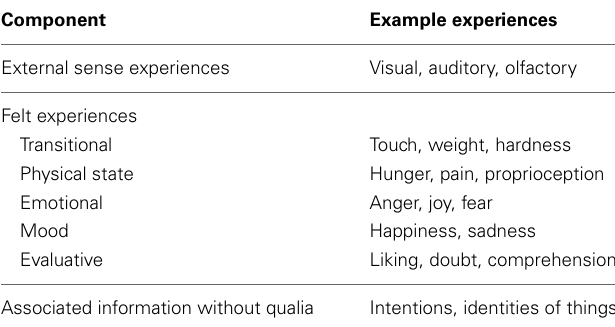
Table 1 | The components of conscious